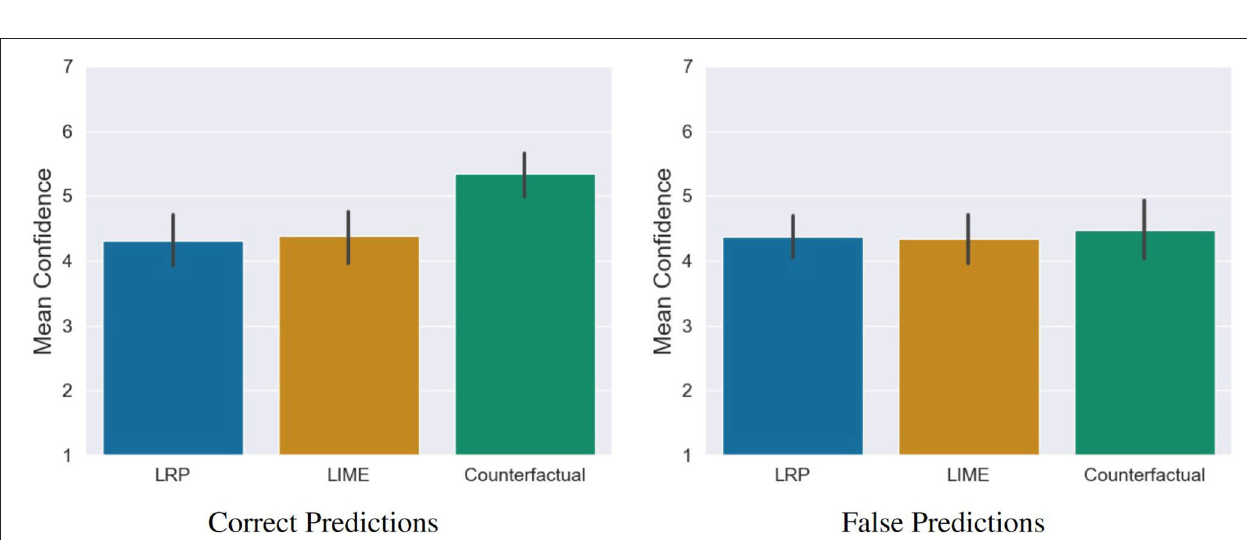
FIGURE 11 | Confidence of the participants in correct and false predictions. The significant difference between the counterfactual condition and the saliency map conditions is based on the confidence in correct predictions, not in the incorrect ones. Error bars represent the 95%